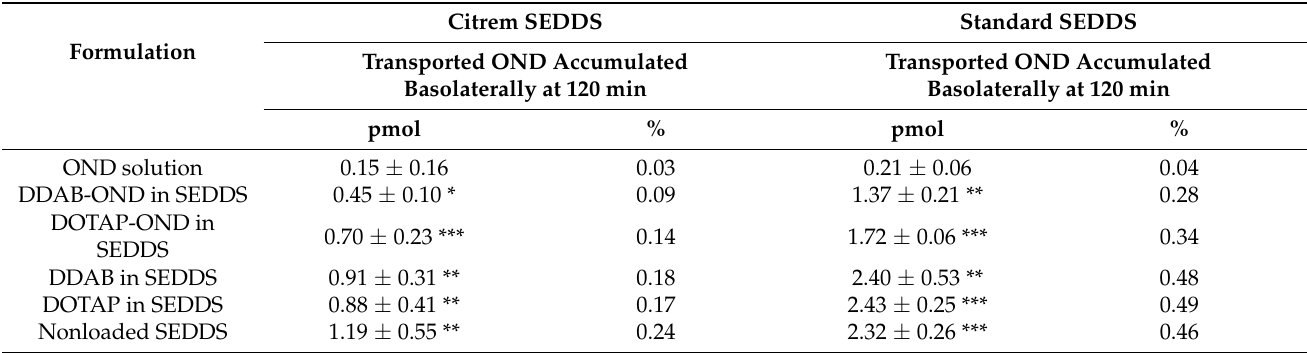
Table 8. Transported OND accumulated in the basolateral compartment after 120 min presented as the total mass (pmol) and % of the initial apical